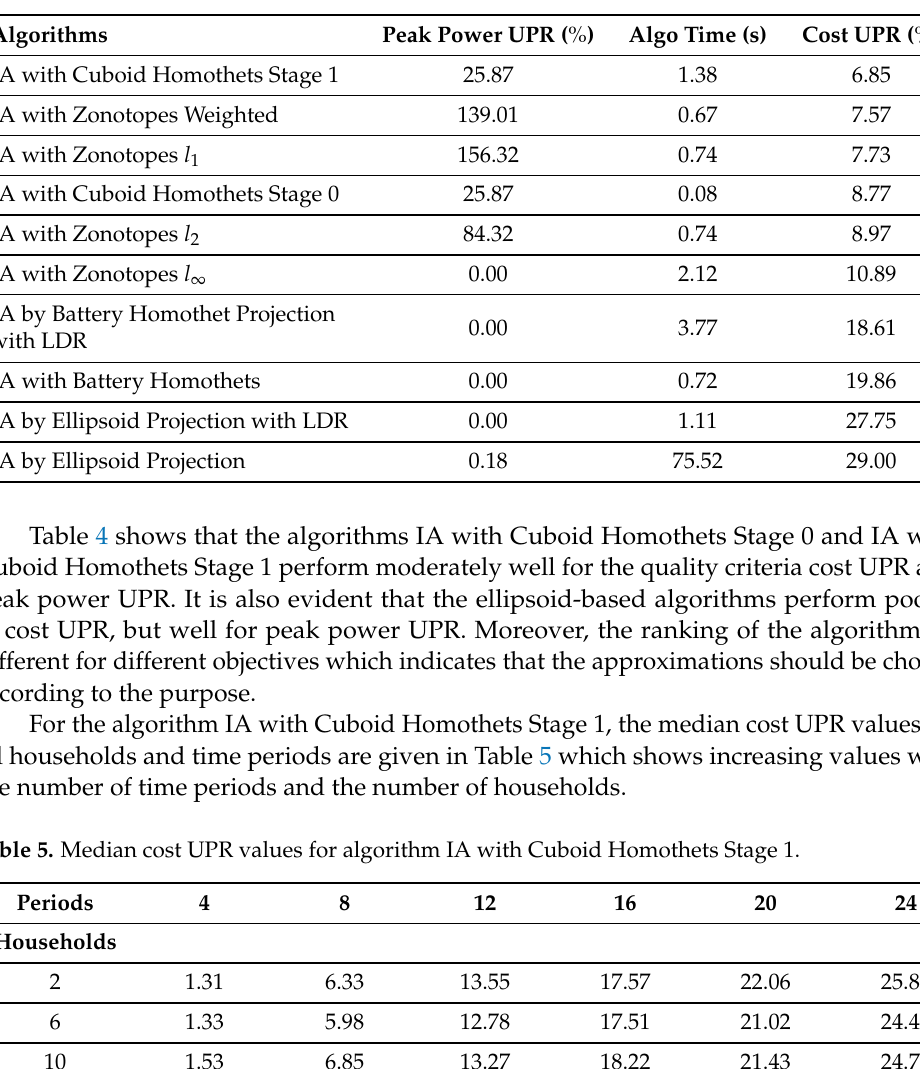
Table 4. Median values for inner approximations with N = 10 and M = 8.